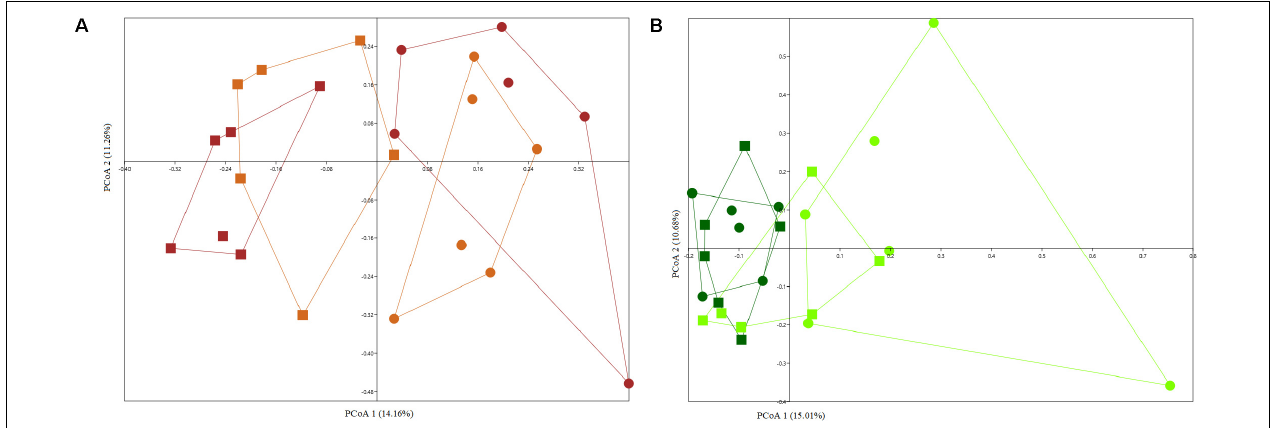
FIGURE 4 | PCoA plots based on Jaccard distance matrix of culturable bacterial communities from the rhizosphere (A) and endosphere (B) of wheat grown in continuous arable or bare fallow soil. The percentage shown on each axis corresponds to the proportion of variation explained. Solid squares represent continuous arable soil and solid circles represent bare fallow soil. Light brown color represents wheat rhizosphere samples derived from the culturing of excised embryos and brown color indicates samples from the rhizosphere of complete seed-derived wheat plants. Dark green color represents samples obtained from the endosphere of complete seed-derived wheat plants and light green color represents samples from endosphere of wheat plants generated from excised